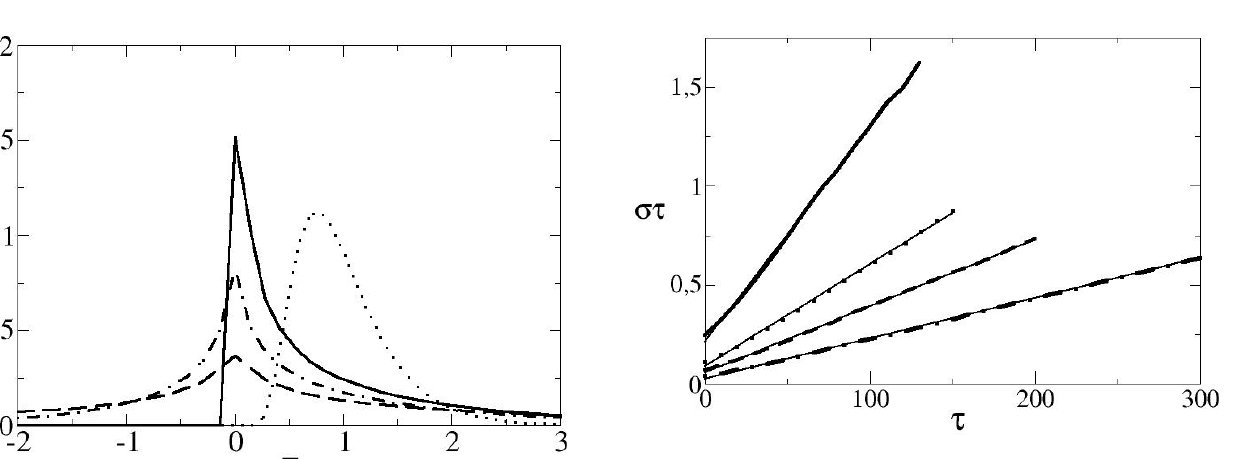
Figure 4. Scaling exponents for t = 10 full line, 20 dotted line, 30 dashed line and 50 dashed-dotted line, as a function of τ and their τ at t = 300 and linear fit (thin full lines); the slope is σ